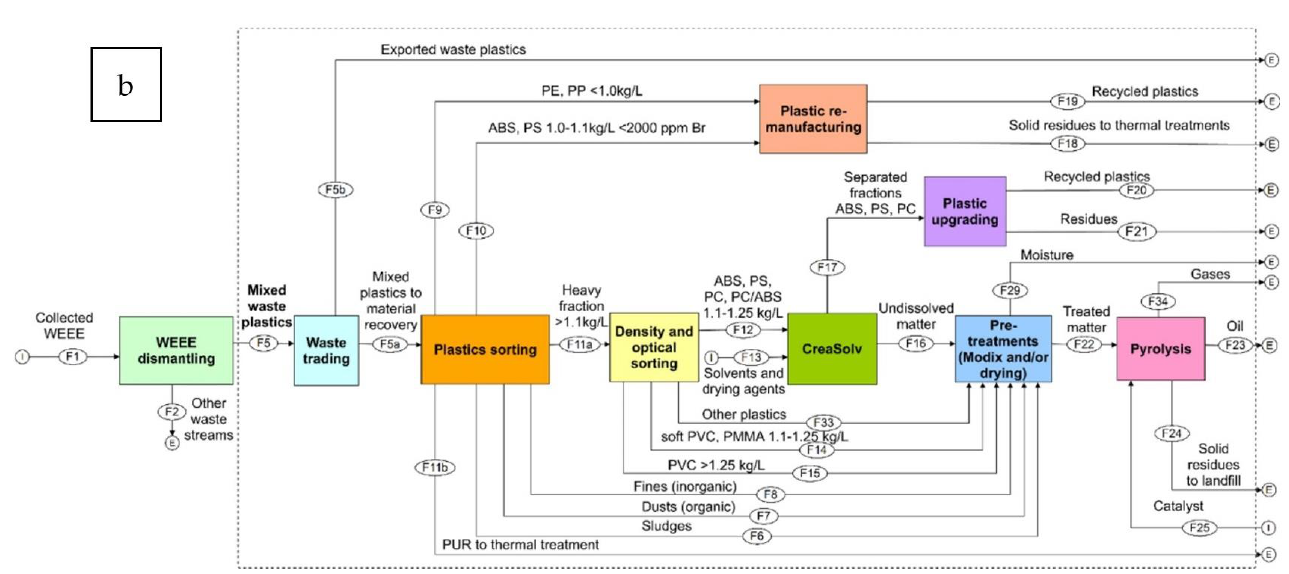
Figure 32. Comparison of the ( a ): current and ( b ): novel management pathways for WEEE plastics. Reprinted with permission from ref. [92].